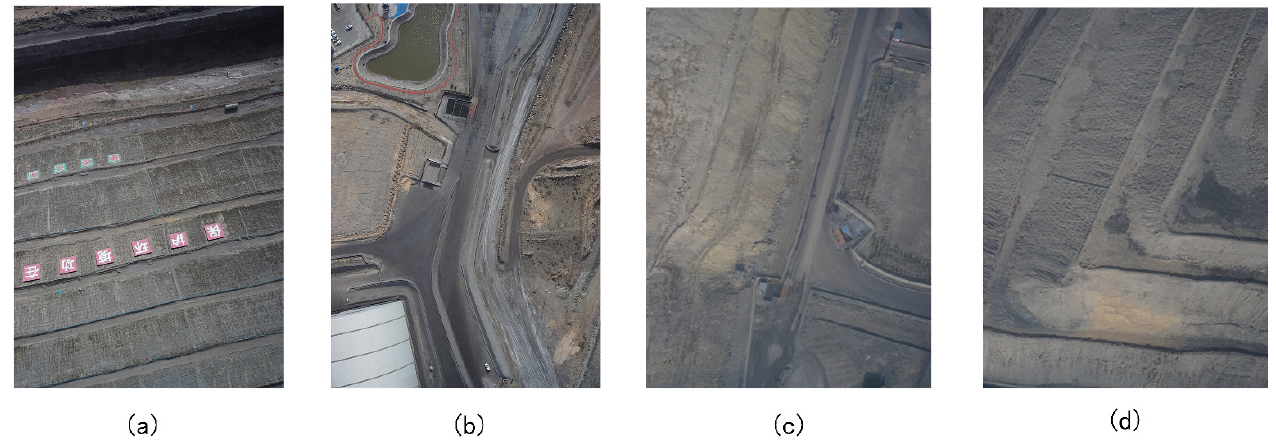
Figure 11. Some of the more representative images in the dataset. ( a ) pictures of mining meadows, ( b ) pictures of the mine road, ( c ) pictures of mining land, ( d ) pictures of mining